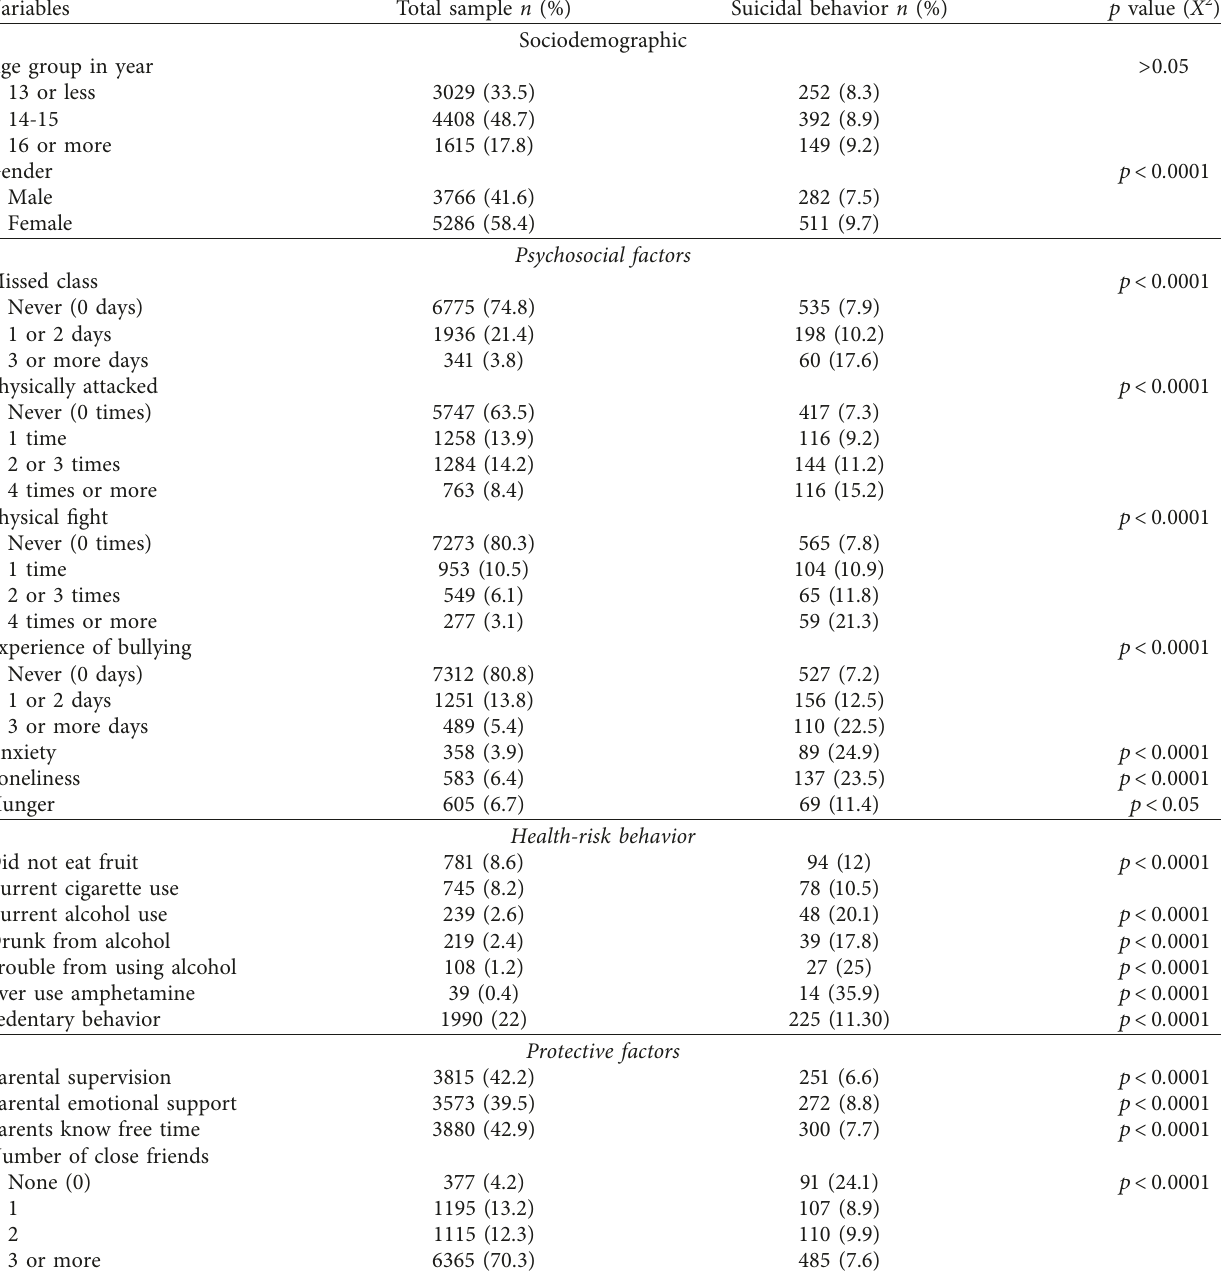
Table 2: Demographic characteristics and their associations with suicidal behavior ( n � 9052).